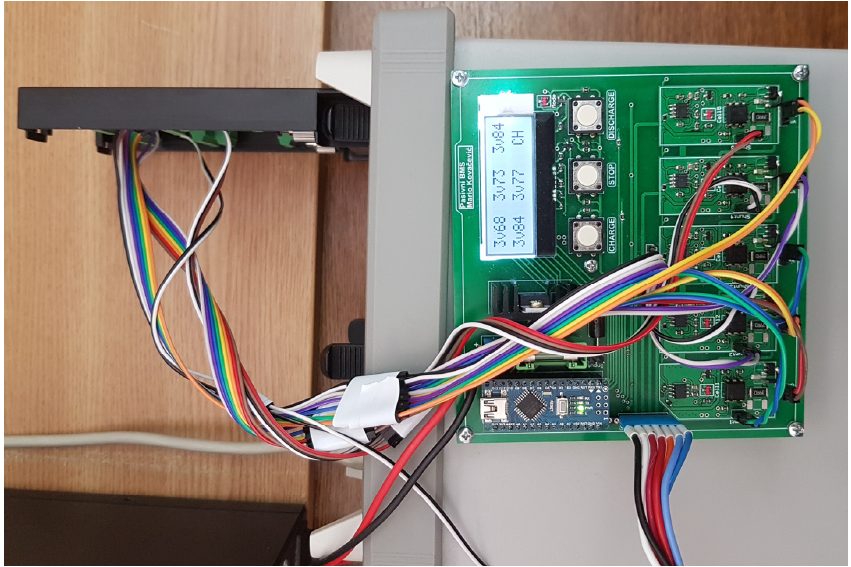
Figure 13. Passive BMS PCB in operation.